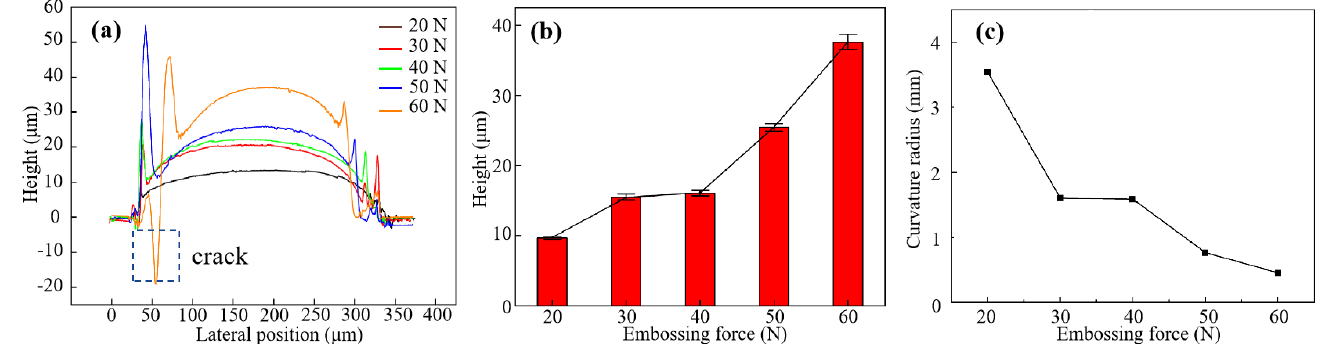
Figure 7. ( a ) Profiles, ( b ) maximum heights, and ( c ) curvature radii of microlenses under various embossing forces.